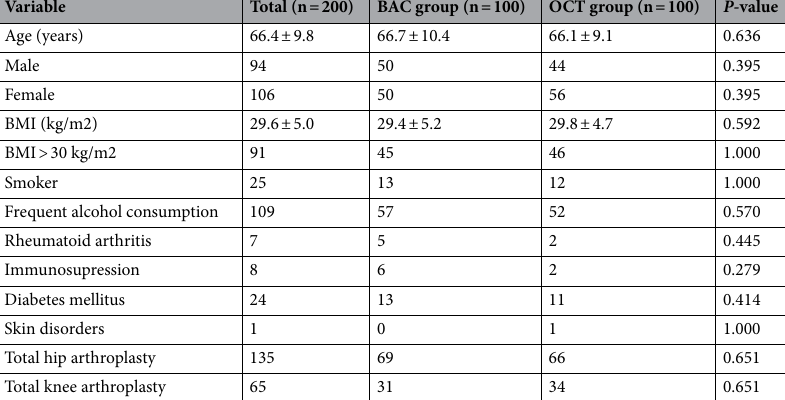
Table 1. Baseline demographics and clinical characteristics. BAC group: alcohol-based antiseptic with additional benzalkonium chloride; OCT group: alcohol-based antiseptic with additional octenidine